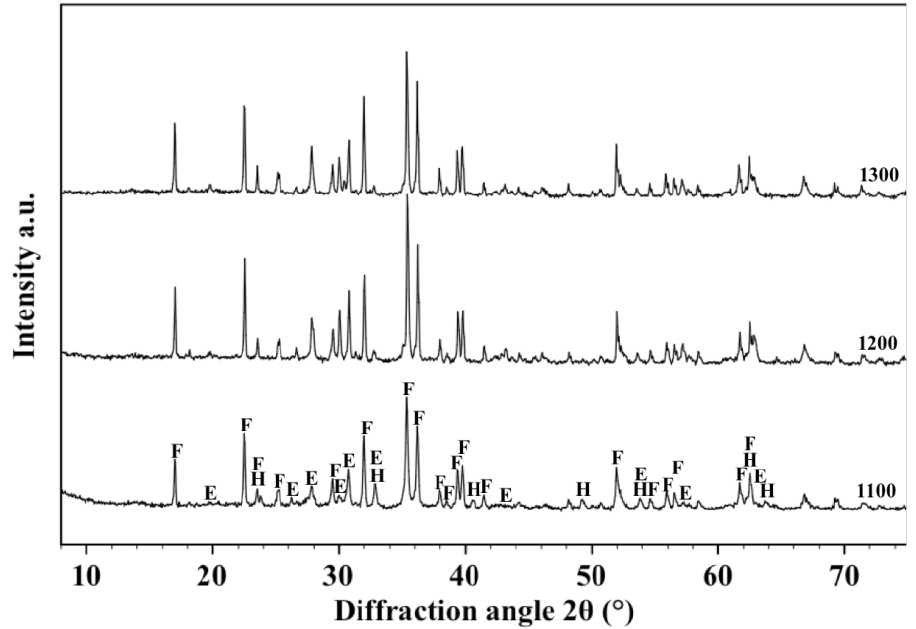
Figure 3. X-ray diffraction patterns between 10° and 70° acquired on the free surface of samples made with O alone fired at 1100, 1200 and 1300 °C. Phases are identified by